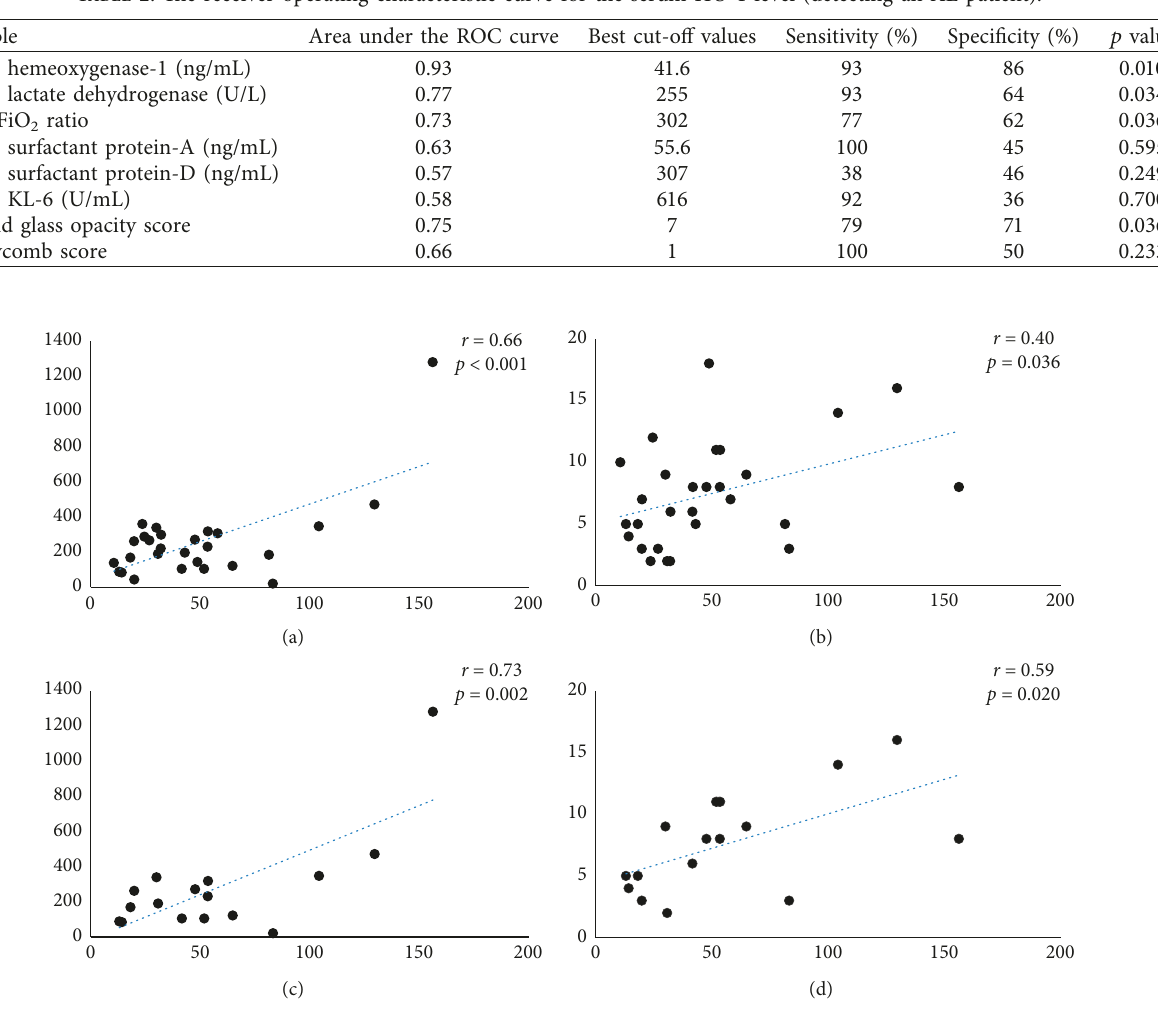
Figure 2: Relationship between the serum hemeoxygenase-1 (HO-1) level and blood biomarker levels. There was a significant correlation between the serum HO-1 and the serum surfactant protein- (SP-) D and the ground glass opacity (GGO) score; however, there was no significant correlation of serum HO-1 with serum KL-6 or with the honeycomb score both in all enrolled patients (a, b) and IPF patients (c,